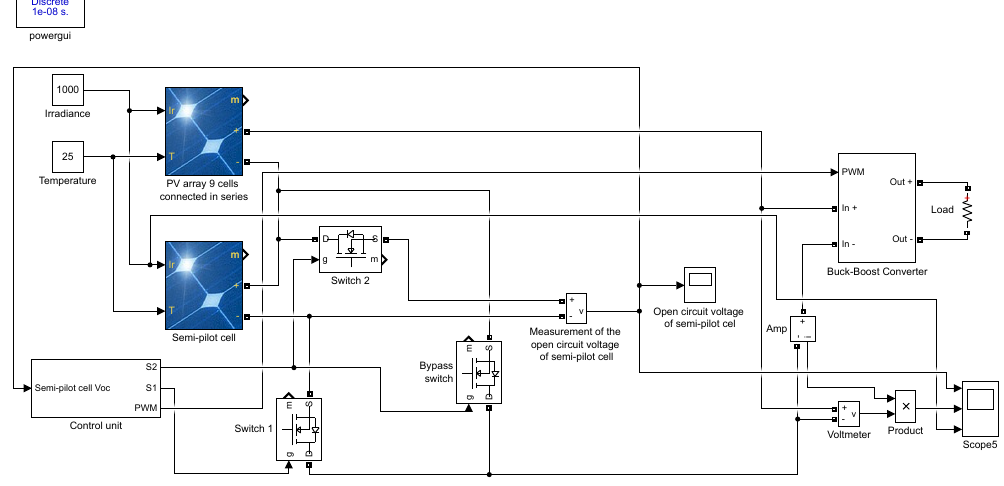
Figure 6. Simulation setup of SPC-FOCV